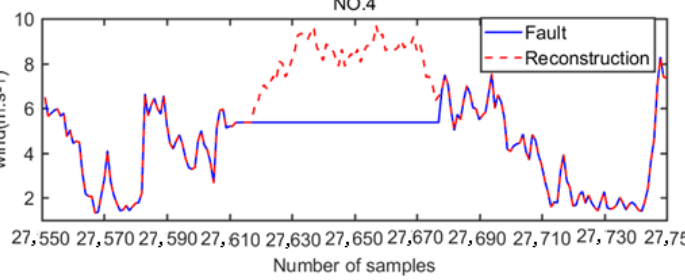
Figure 10. Faulty wind speed of No. 4 wind turbine in 2014.